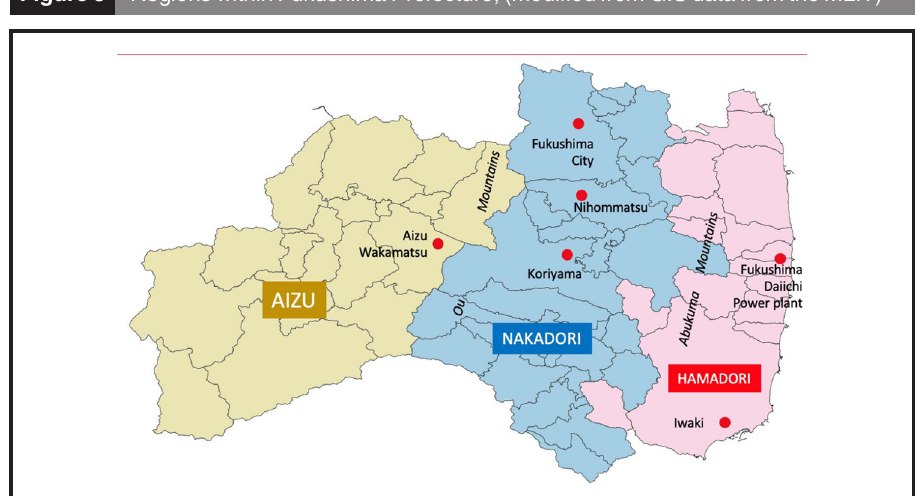
Figure 5 Regions within Fukushima Prefecture, (modi fi ed from GIS data from the